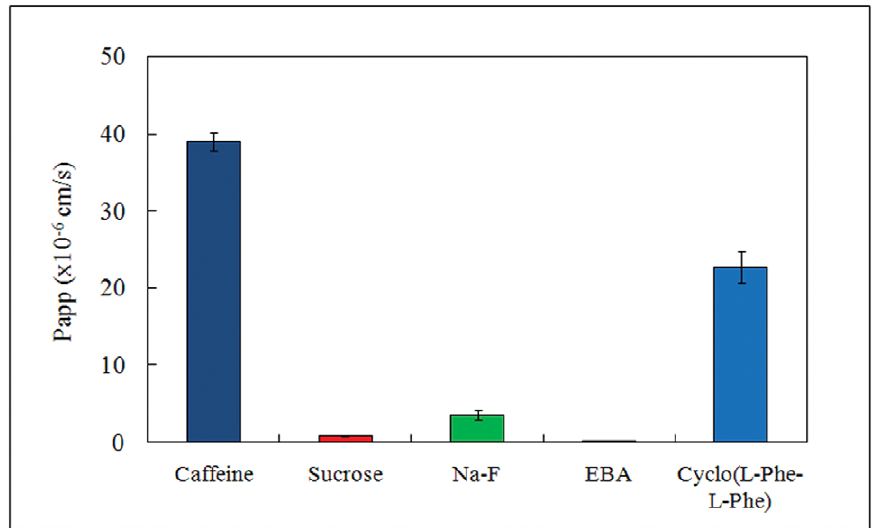
Figure 2. Apparent permeability coefficient (Papp) of cyclo( L -Phe- L -Phe) measured using a blood–brain barrier (BBB) invitro model. Papps of caffeine, sucrose, Na-F, Evans blue albumin (EBA), and cyclo( L -Phe- L -Phe) were measured and calculated.